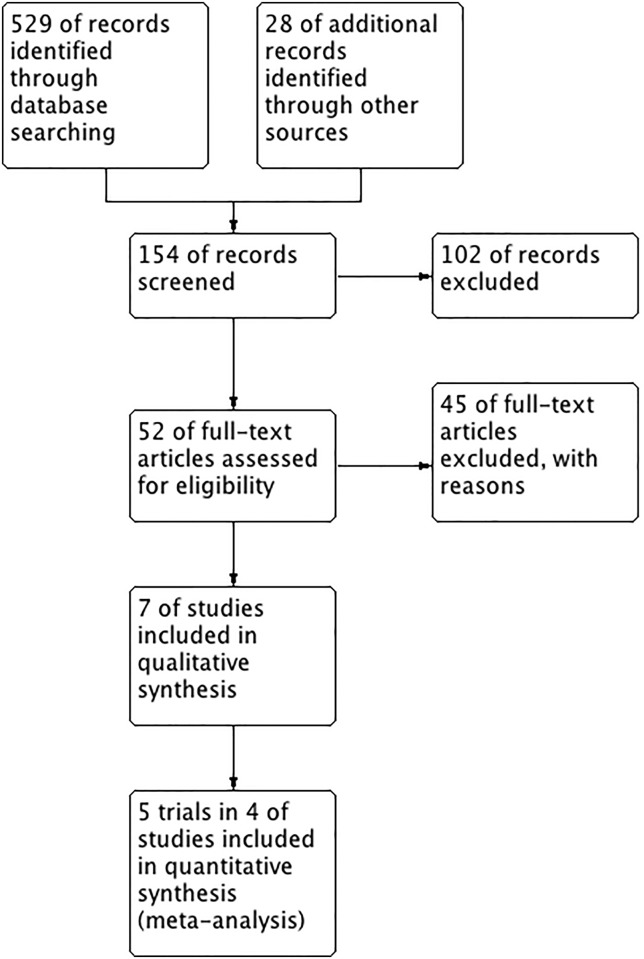
PRISMA flow diagram.